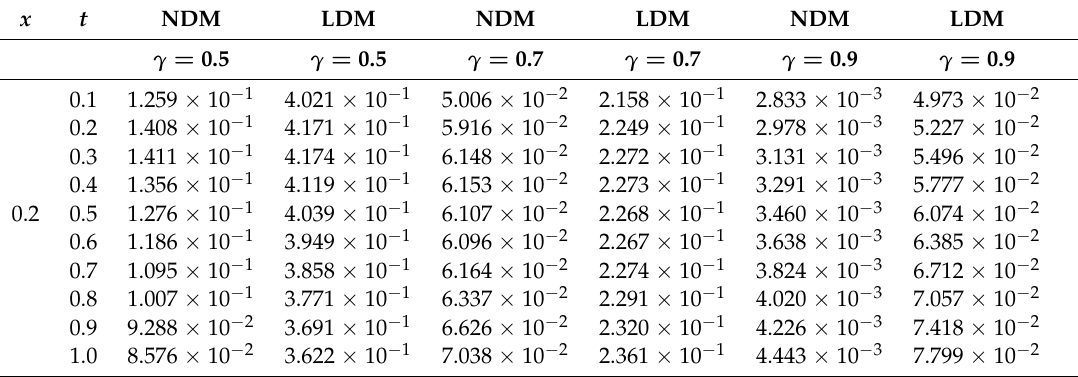
Table 2. Two terms comparison of NDM and LDM [16] of different fractional-order at γ = 0.5, 0.7 and 0.9 of Example 1.